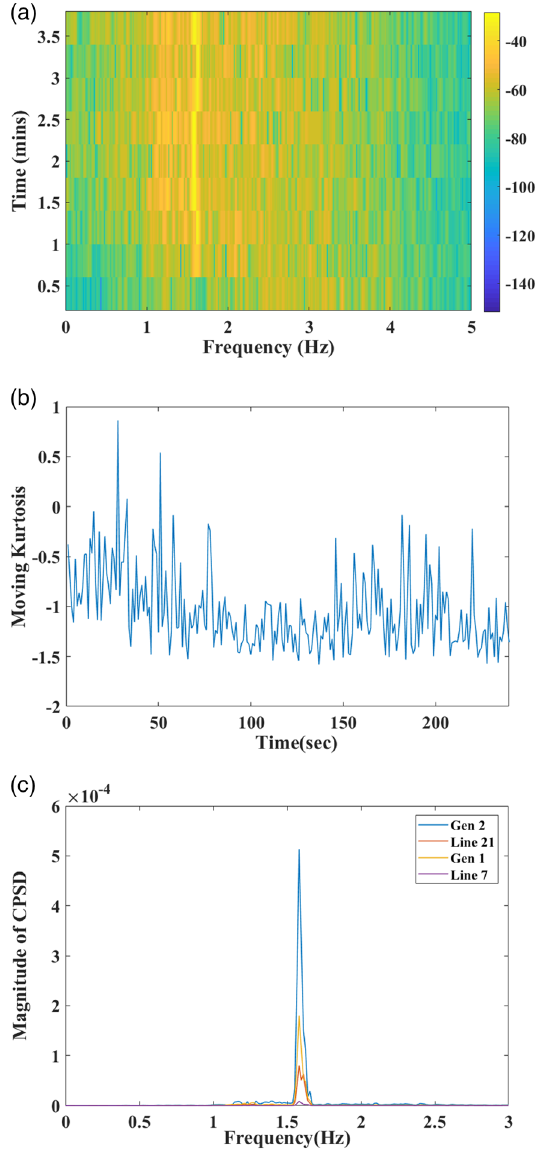
Fig. 13 a PSD of the selected DMAP. b Excess Kurtosis. c Magnitude of CPSD between the selected DMAP and raw PMU data from different buses associated with generation source